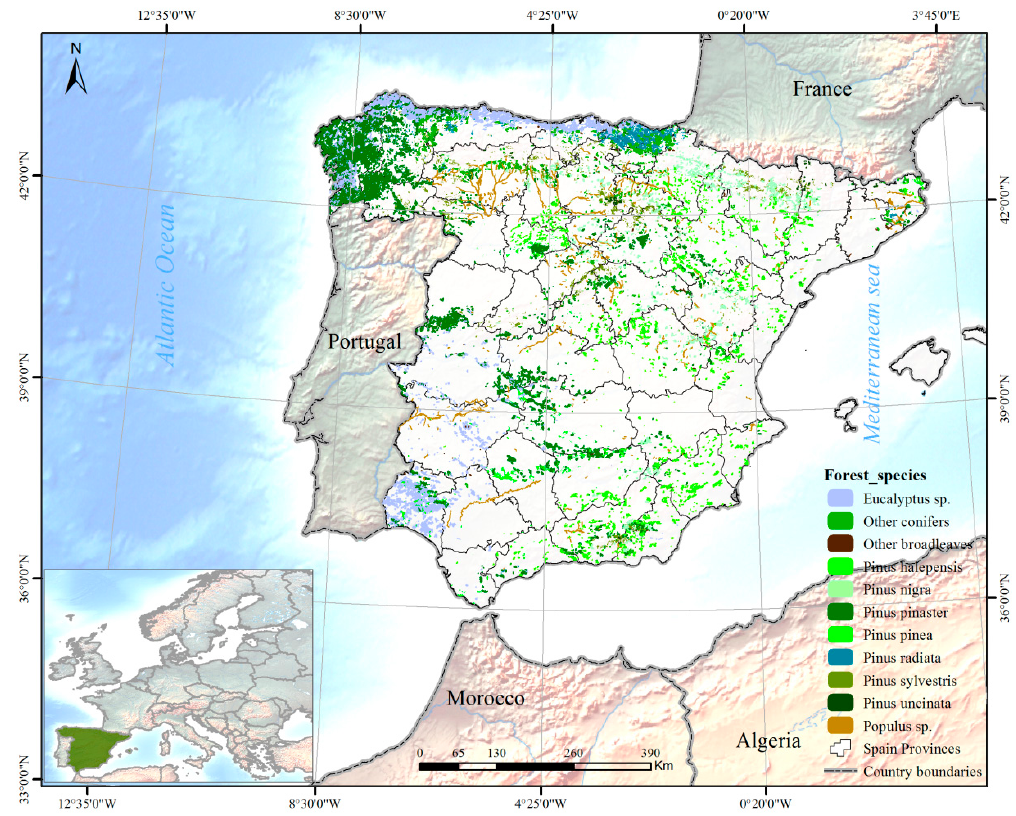
Figure 1. Map of reforested areas in Spain. (Source: adapted from Ruiz de la Torre, 1990)